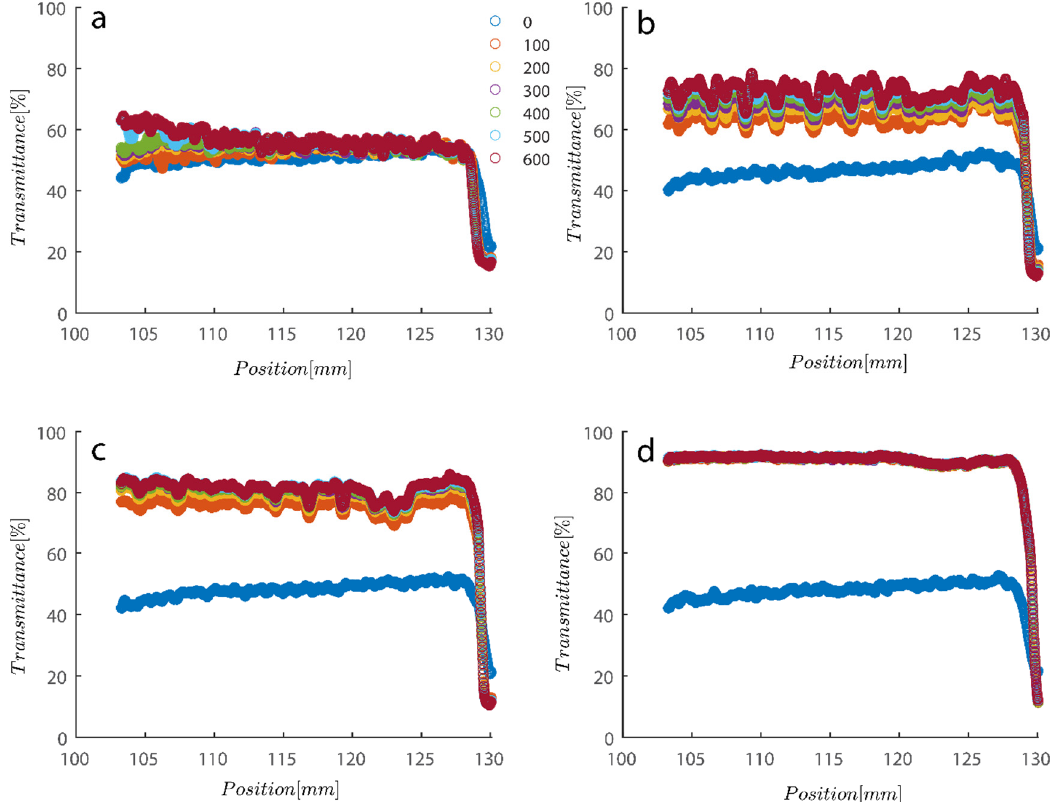
Figure 7. Transmission profiles obtained during centrifugation of a kaolinite sample Sigma I: ( a ) 200, ( b ) 500, ( c ) 1000, ( d ) 4000 RPM at 0.1 wt% concentration. Position of illuminated cell varies between 103–130 nm; the low transmission at the end of the cell demonstrates that particles are accumulat- ing